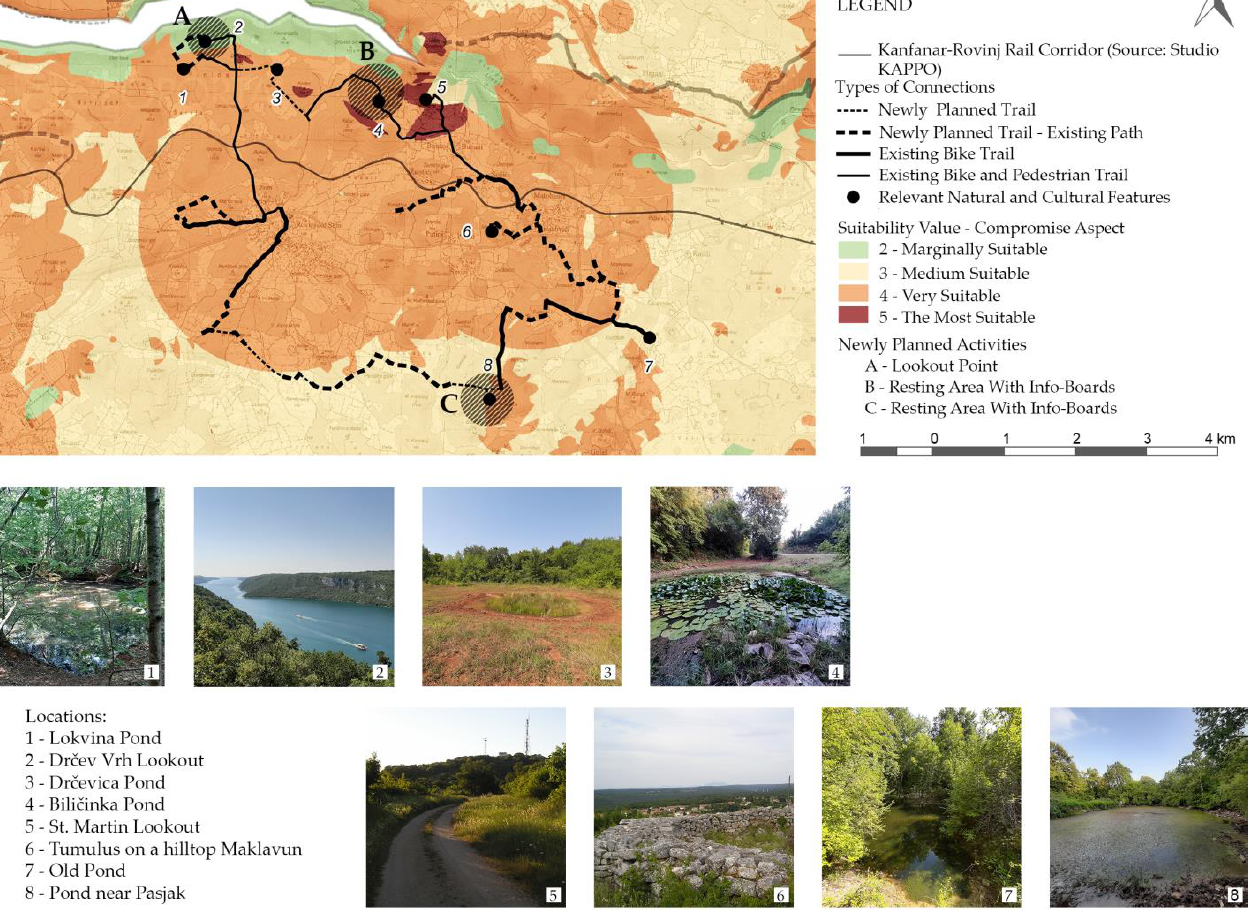
Figure 8. The Kuntrada functional area.